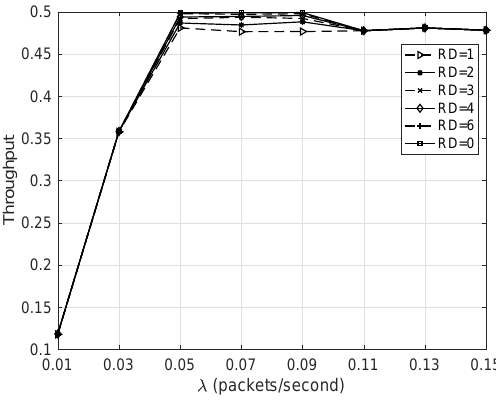
Figure 6. Throughput versus λ .